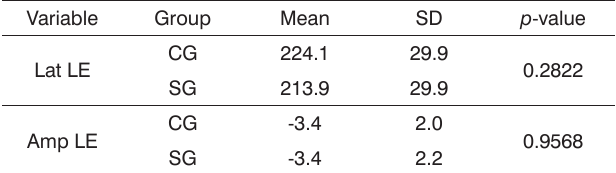
Table 6 . Descriptive statistics of the mean, standard deviation (SD) and p -value of the MMNf amplitude and latency for the LE.